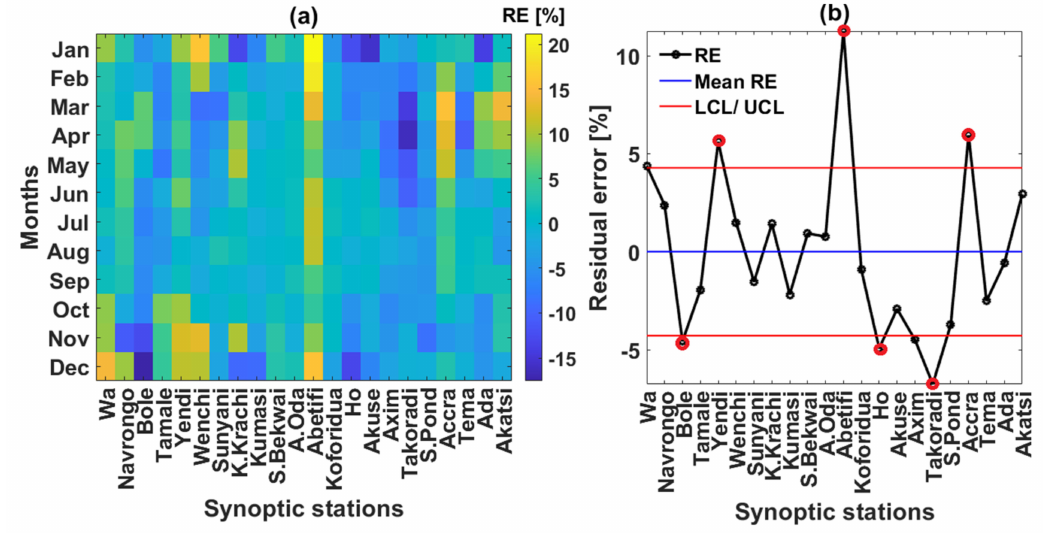
Figure 5. ( a ) Color plot depicting the climatological variations of residual errors (RE) between TCC o and TCC e , and ( b ) control chart depicting station-by-station variation in mean RE within the lower control limit (LCL) and upper control limit (UCL) of the standard deviation of